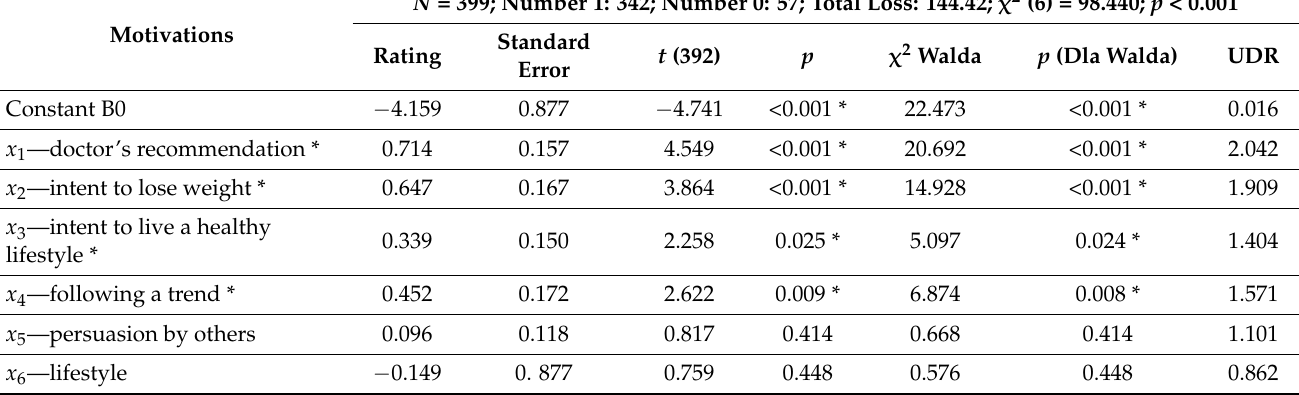
Table 4. Logistic regression model (logit)—motivations of young Poles for employing healthy eating habits.